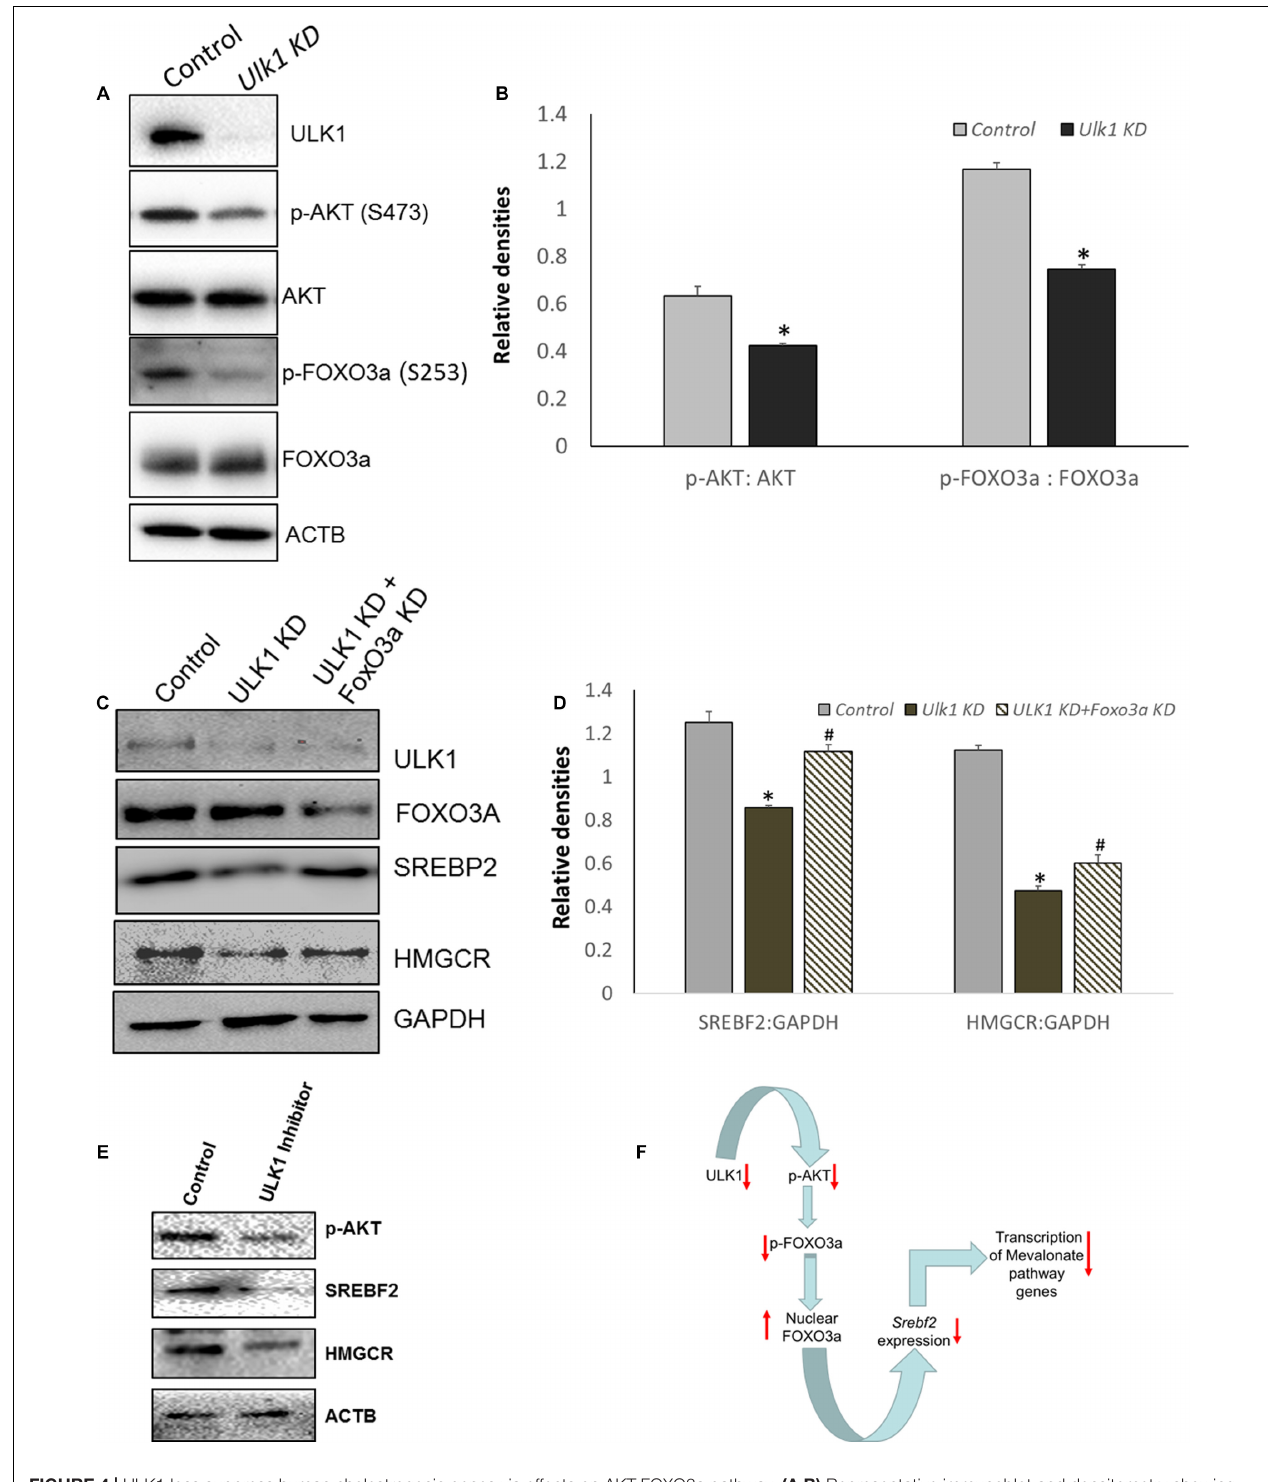
Frontiers in Cell and Developmental Biology |